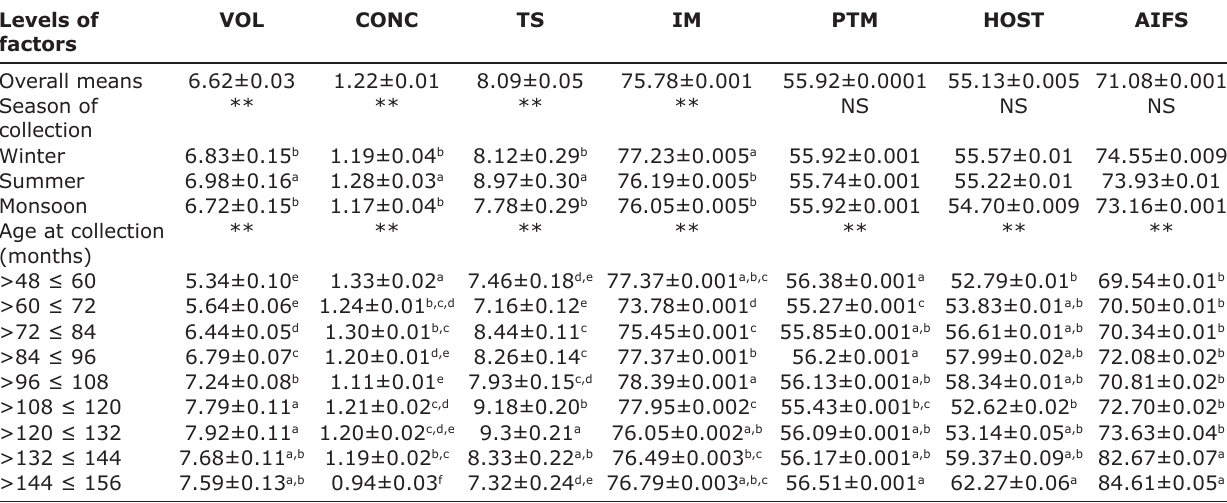
Table-1: Least square means ± SE and number of observations for the effect of age and season of collection on semen traits of Gir bulls. Levels of VOL factors Overall means Season of collection Summer